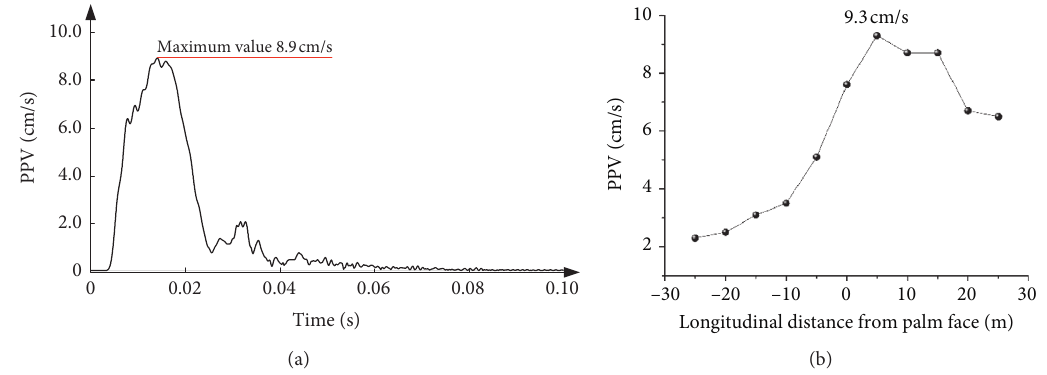
Figure 27: PPV of the right wall after adopting the new scheme. (a) Numerical simulation. (b) On-site